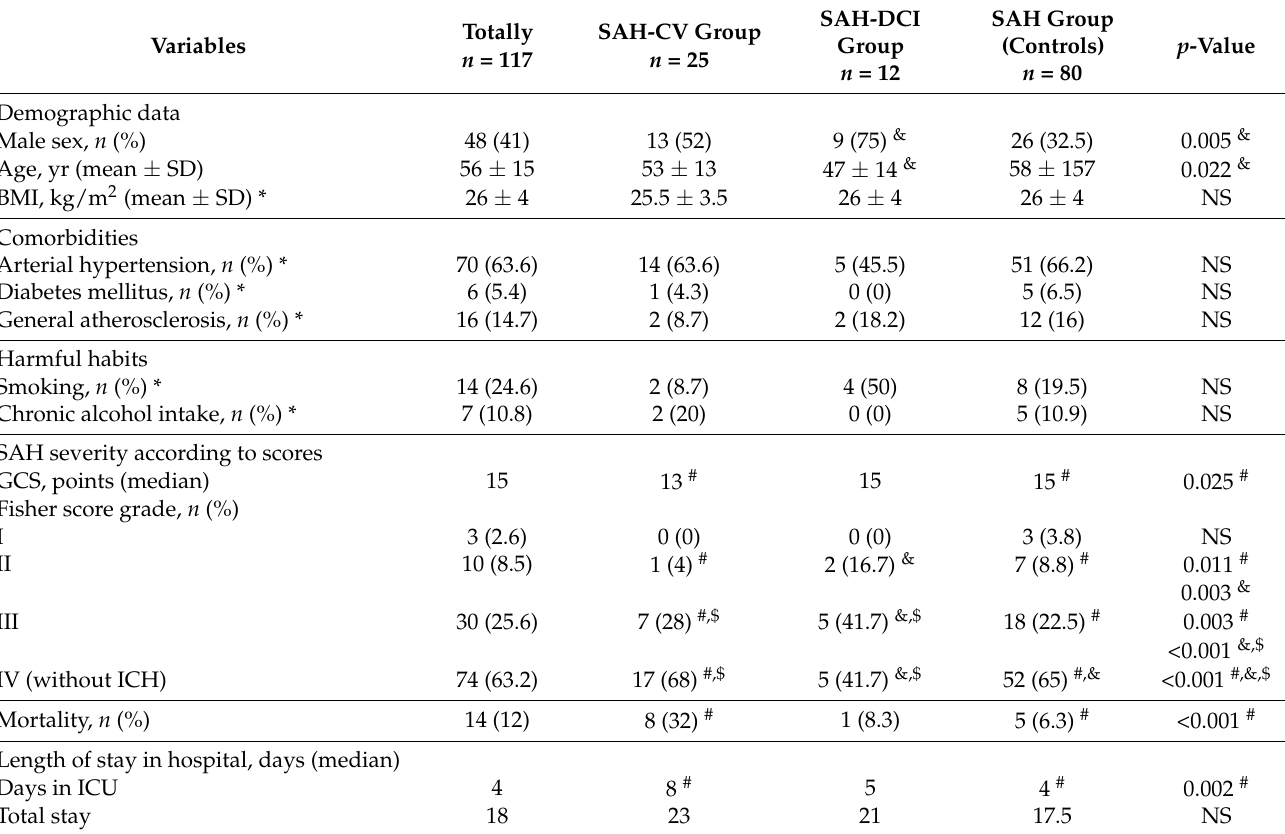
Table 1. Descriptive statistics of patients with aSAH admitted to Intensive Care